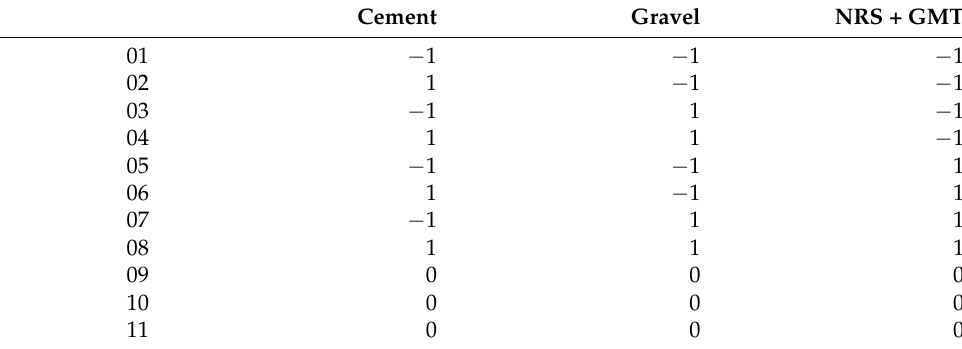
Table 3. Coded matrix of the full factorial design.